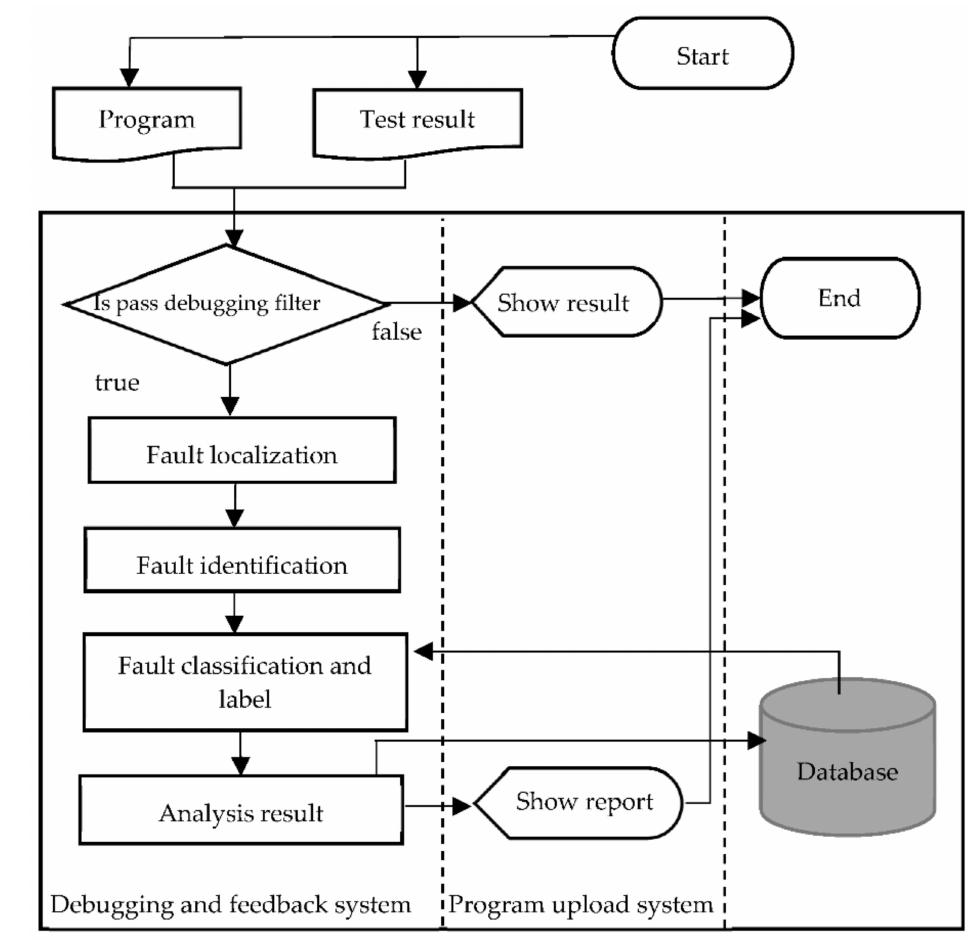
Figure 7. System flow chart.